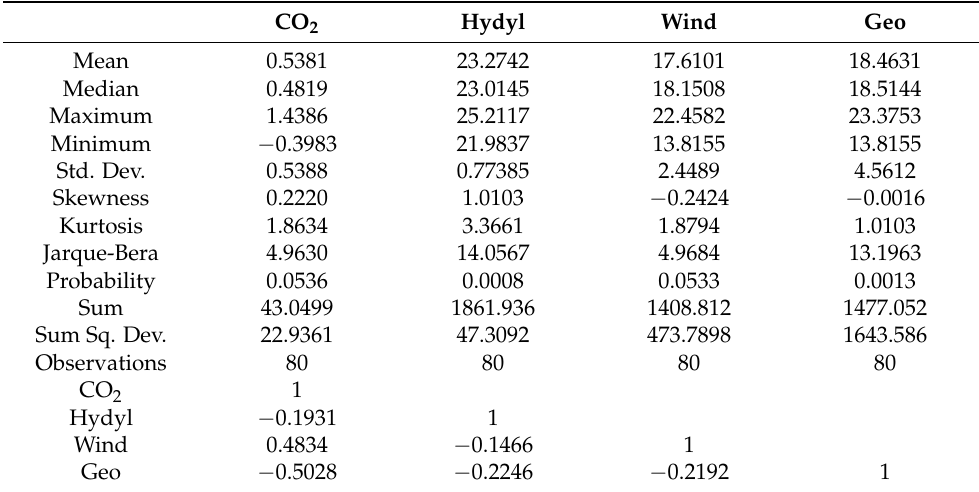
Table 1. Results of Descriptive